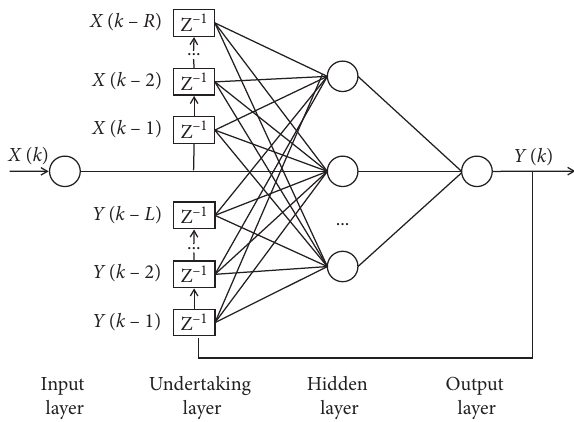
Figure 3: Schematic diagram of NARX neural network